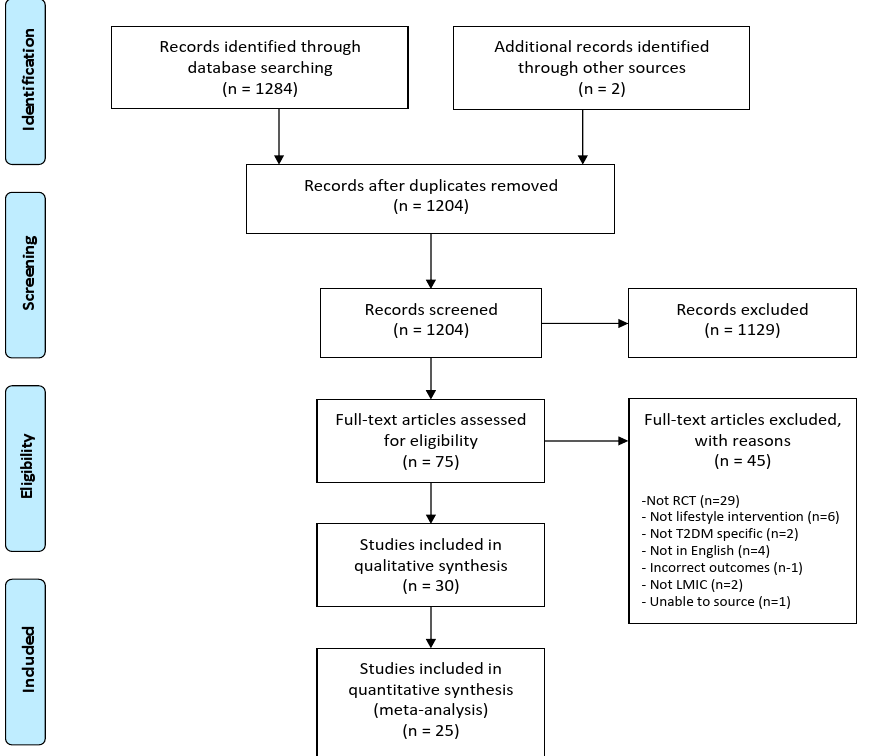
Figure 1. PRISMA study flow diagram.